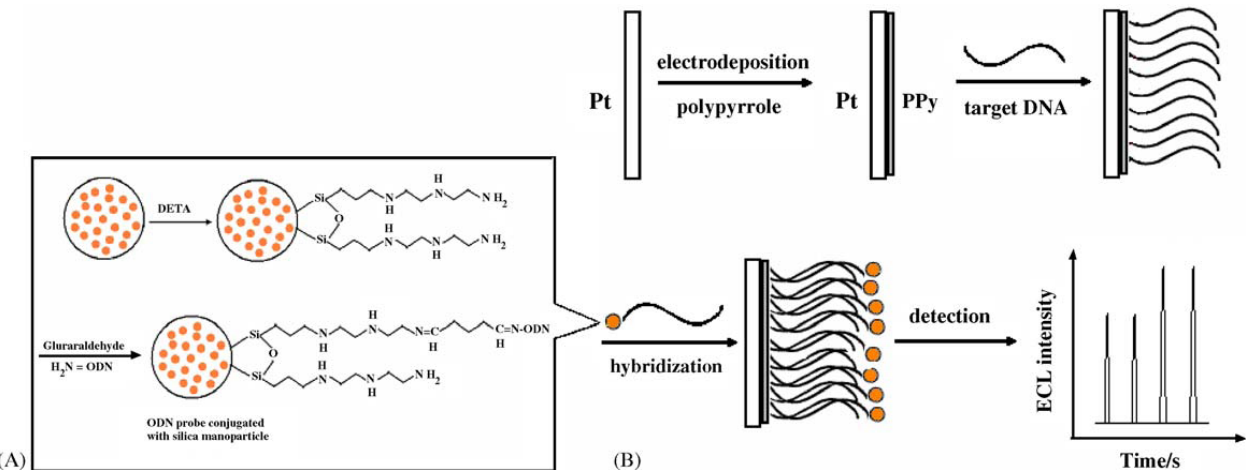
Figure 5. Schematic representation of preparation Ru(bpy) 32+ -doped silica nanoparticles oligonucleotides probes (A) and the electrogenerated chemiluminescence detection of DNA hybridization based on the Ru(bpy) 32+ -doped silica nanoparticles labeled oligonucleotides probes (B). Reprinted from Ref [72] with permission from